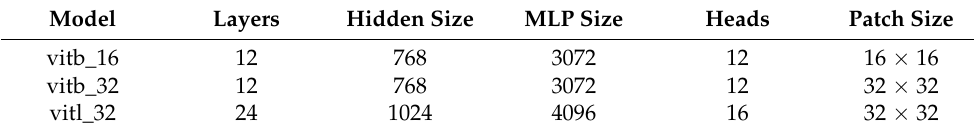
Table 1. Vision transformer model details.